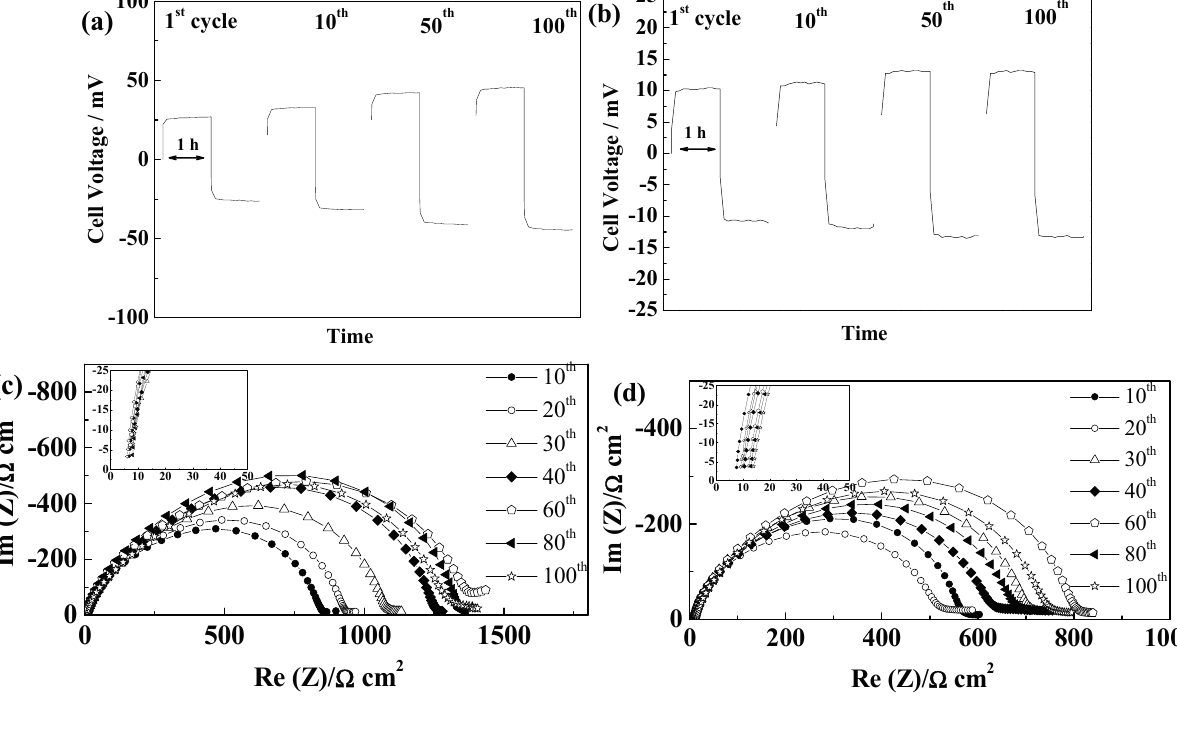
Figure 14. Evolution of Separion ® cells during cycling at 40 °C and 0.1 mA·cm − 2 ( a ) Voltage profiles of a PYR ( c ) Evolution of the impedance spectra at 20 °C of a PYR the impedance spectra at 20 °C of a PYR